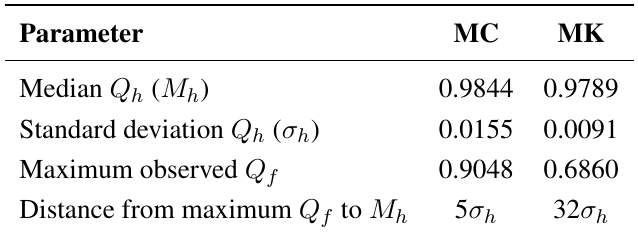
Table 2. The Q values presented in Figure 9 can be divided in two categories: healthy state ( Q ) and failure state ( Q ). MK sensors have a smaller σ h f Q values and Q values, making Q a more effective estimator for microphone failure in h f MK